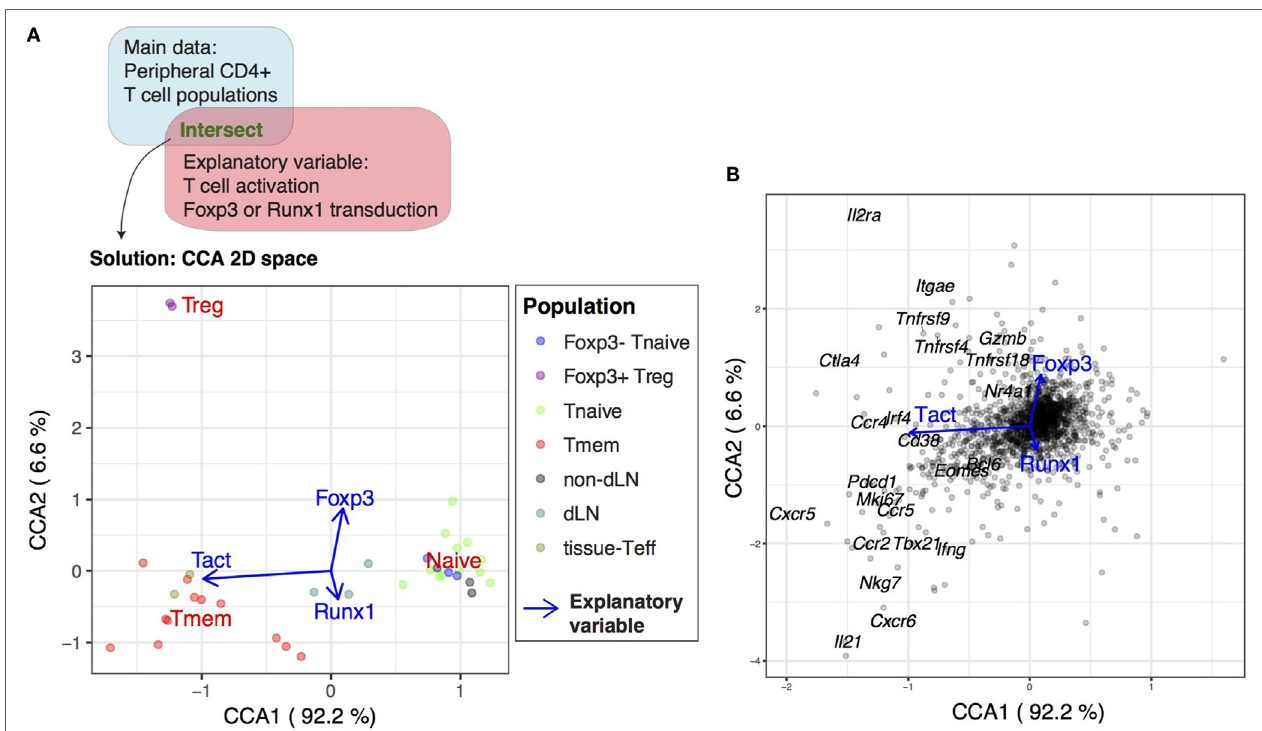
FigUre 3 | Identification of the Foxp3-independent activation signature in Treg by canonical correspondence analysis (CCA) of T cell populations. The microarray dataset of peripheral CD4 + T cells (GSE15907) was analyzed using the T cell activation variable and the variables for retroviral Foxp3 transduction and Runx1 transduction as explanatory variables. (a) The CCA solution was visualized by a biplot where CD4 + T cell samples are shown by closed circles (see legend) and the explanatory variables are shown by blue arrows. Percentage indicates that of the variance accounted for by the inertia of the axes (i.e., the amount of information [eigenvalue] retained in each axis). (B) Gene biplot of the 2D CCA solution in (a) showing the relationships between genes (gray circles) and the explanatory variables (blue arrows). Selected key genes are